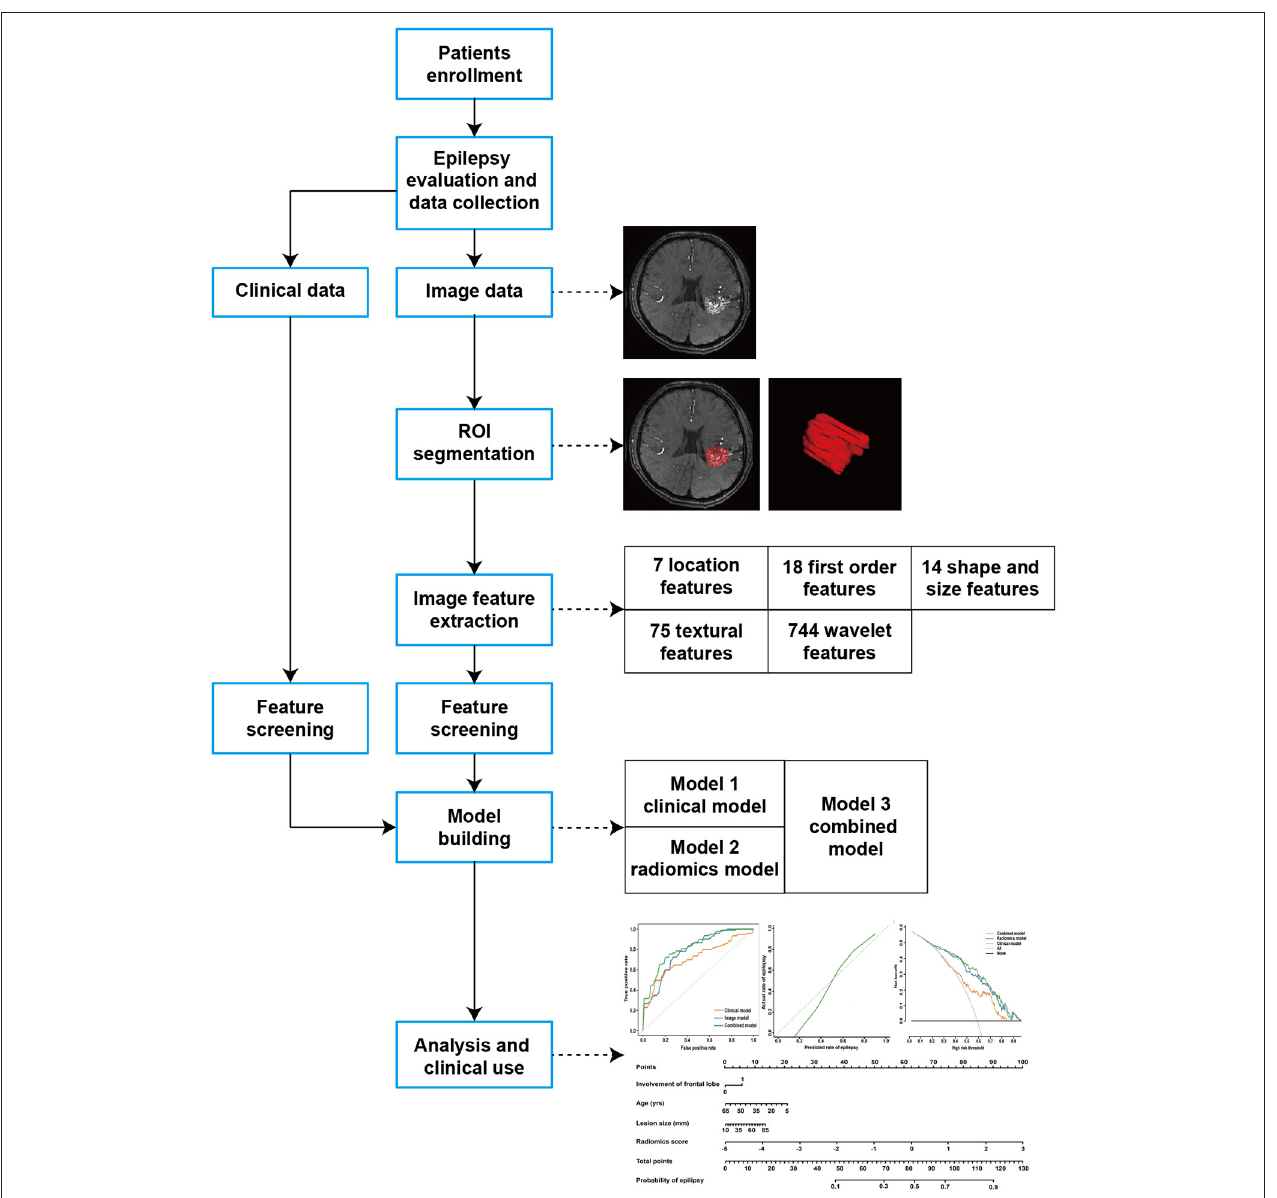
FIGURE 1 | The workflow of the